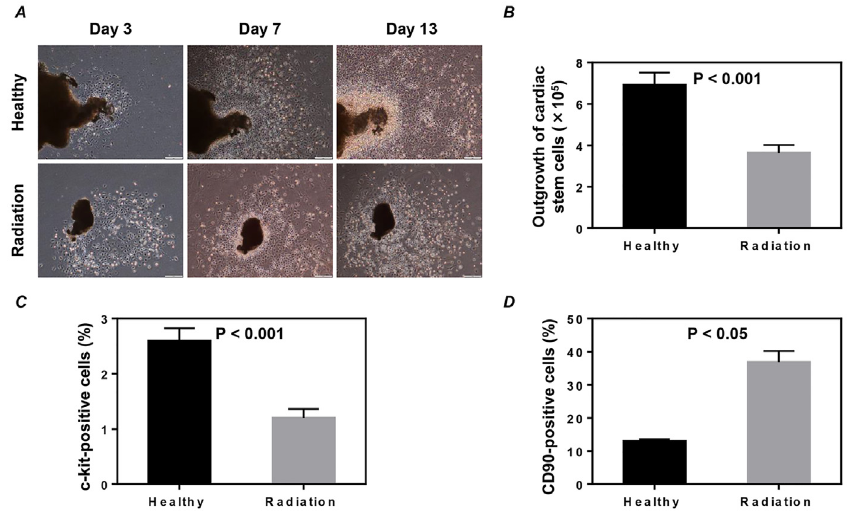
Fig 3. Ex vivo expansion and phenotypic characterization of cardiac stem cells (CSCs). (A) Representative images of CSCs expanded from the explants of heart atrial tissues. Scale bar: 50 μ m. (B) CSCs were harvested at day 14, and the number of total collected CSCs from each mouse was directly counted. Values shown are the mean ± SEM of 6 independent experiments. The phenotypic characterization of c-kit (C) and CD90 (D) was determined by immunostaining of twice-passaged CSCs. Quantitative data of the expression of c-kit and CD90 were obtained by counting positively stained cells from 20 randomly selected fields. Values shown are the mean ± SEM from 6 independent experiments in C and 3 independent experiments in